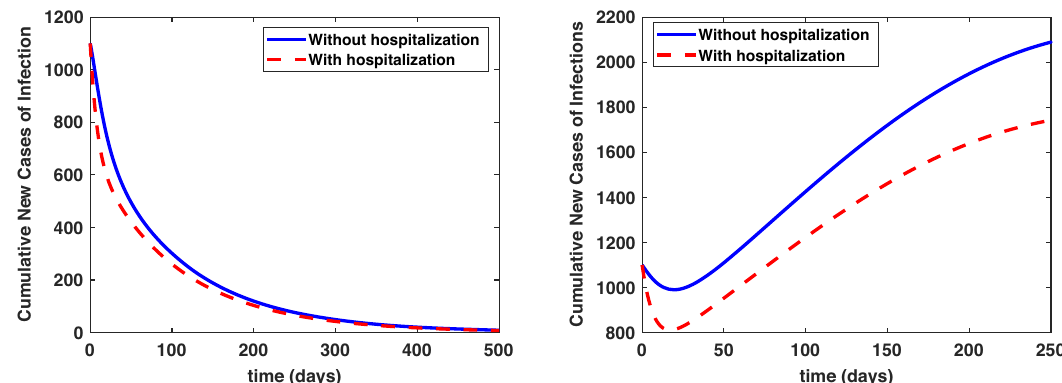
Figure 3: ( Left ) The plot of the cumulative infected compartments as functions of time when = (cid:3) 0.7203 0 . ( Right ) The plot of the cumulative infected compartments as functions of time when